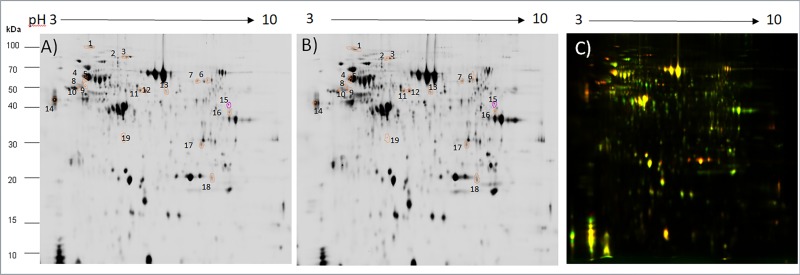
The representative pattern of the supernatant after cryopreservation of good (Cy3, green spots) and poor freezability (Cy5, red spots) semen after 2D-DIGE analysis.Numbers indicate proteins more abundance in the supernatant after cryopreservation of poor freezability semen.